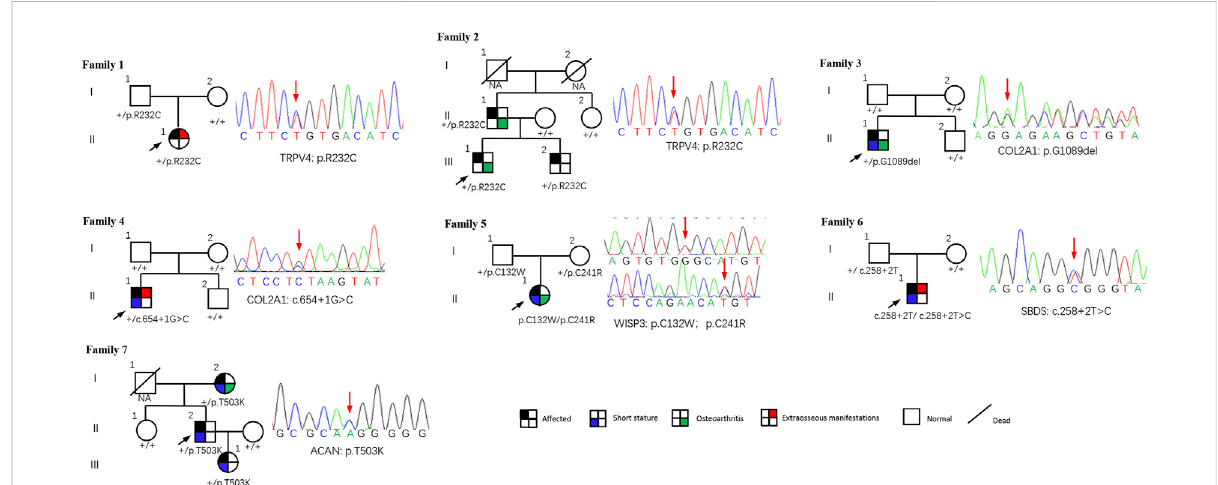
FIGURE 2 Pedigrees ofsevenfamilieswithSEMD. Almostallaccessible familymembersweresequencedandexamined.Mutationsareshown beloweach subject,andthecorrespondingsequencediagramsaredisplayednexttothepedigrees.Circlesandsquaresindicatefemalesandmales,respectively. Arrows identify the proband in the families. Slashes indicate deceased individuals.